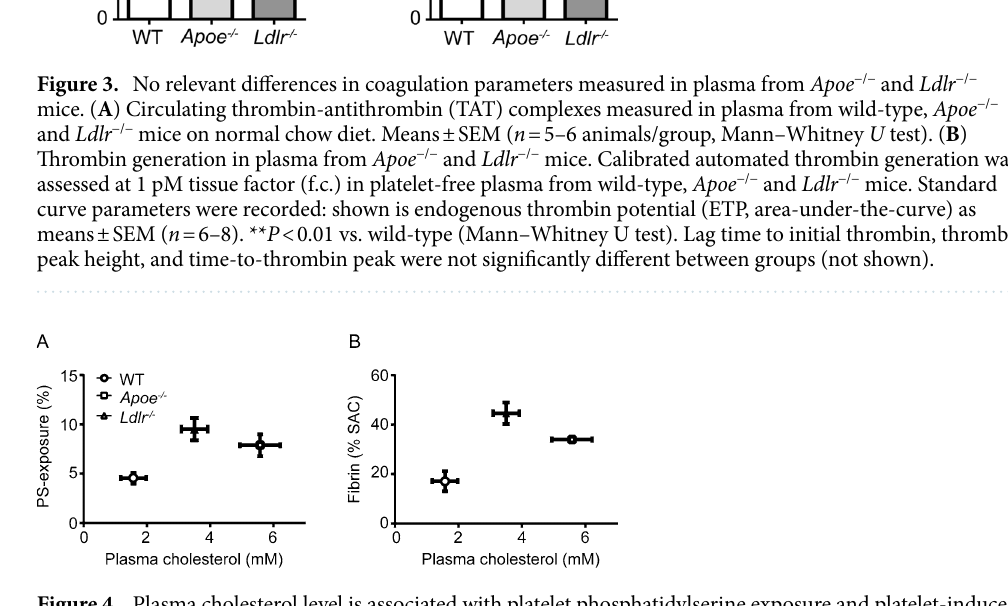
obtained parameters of thrombus formation on two microspots, only 2–8 parameters showed significant dif- ferences between the mouse age groups of all genotypes (Suppl. Figure 3C). In agreement with previous data 24 , the various parameters per microspot were mostly correlated when examined per genotype (Fig. 2C). When comparing the knockout strains, gain-of-function values (represented as yellow–red coloring) were observed for both the Apoe −/− and Ldlr −/− mice, when compared to corresponding wild-types, especially for the fibrin parameters Pc , Pd and Pe . A subtraction heatmap was created for better visualize of differences in terms of effect sizes per parameter (Fig. 2D). This revealed a similar prothrombotic phenotype in phosphatidylserine exposure and fibrin forma- tion for both Apoe −/− and Ldlr −/− mice, especially in the presence of TF. This extended analysis hence suggested that the hyperlipidemic condition in either knockout strain led to an increase in platelet activation and ensuing fibrin formation under flow conditions. To investigate if coagulation processes were altered, platelet-free plasma from the genotypes was analyzed for the presence of thrombin-anti-thrombin (TAT) complexes, as a sensitive marker of ongoing thrombin gen- eration in vivo 25 . No significant differences between the three strains were seen (Fig. 3A). The TF-induced thrombin generation test in plasma showed a slightly increased endogenous thrombin potential for Apoe −/− , only Apoe −/− mice, which however cannot fully explain the increased platelet-dependent fibrin formation during perfusion of whole blood from both Apoe −/− and Ldlr −/− mice.